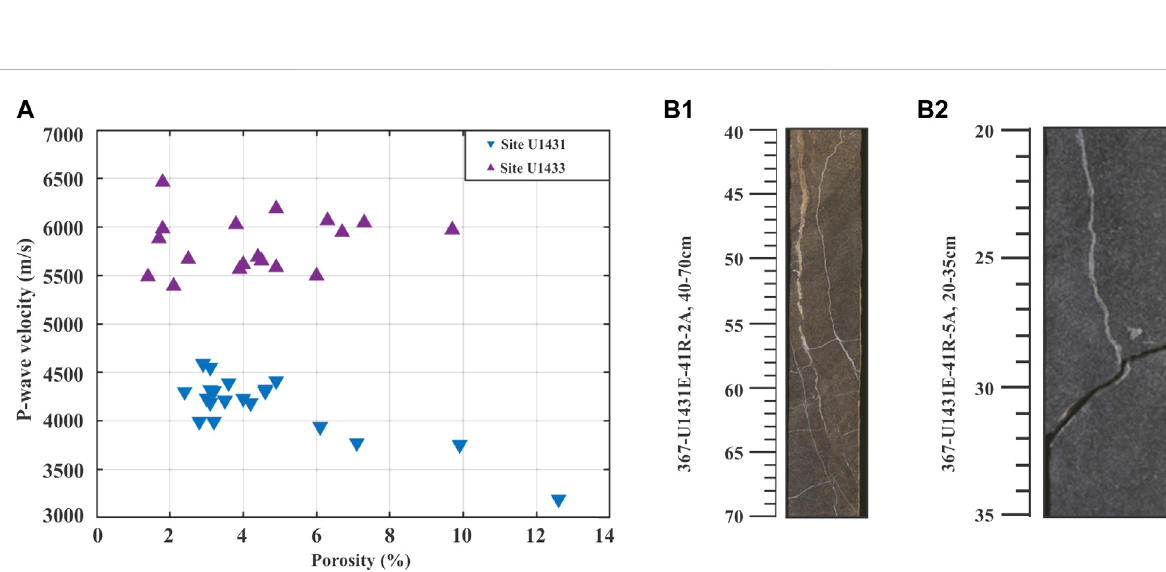
FIGURE 11 (A) CrossplotsofP-wave velocityagainst porosity forbasalt dataofSitesU1431EandU1433B; (B1) Core photoshowingthefractureinU1431E- 41R-2A; (B2) Core photo showing the fracture in